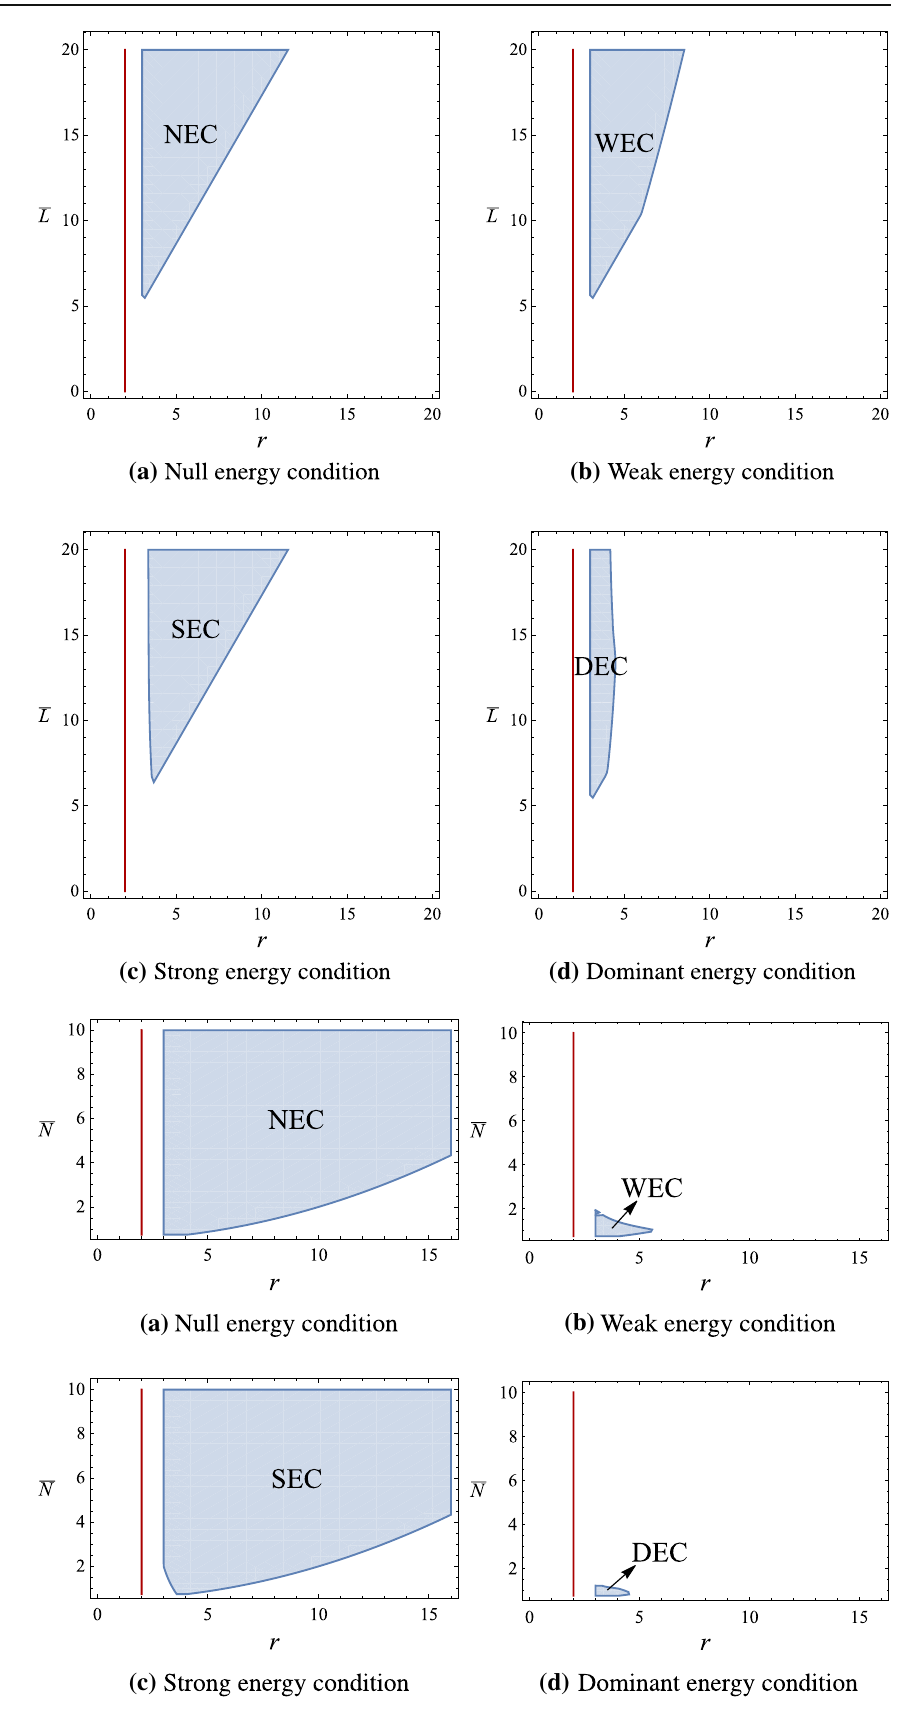
Fig. 11 The blue shadows show the valid domains of various energy conditions for the case of ¯ N = 1. The red lines are horizons